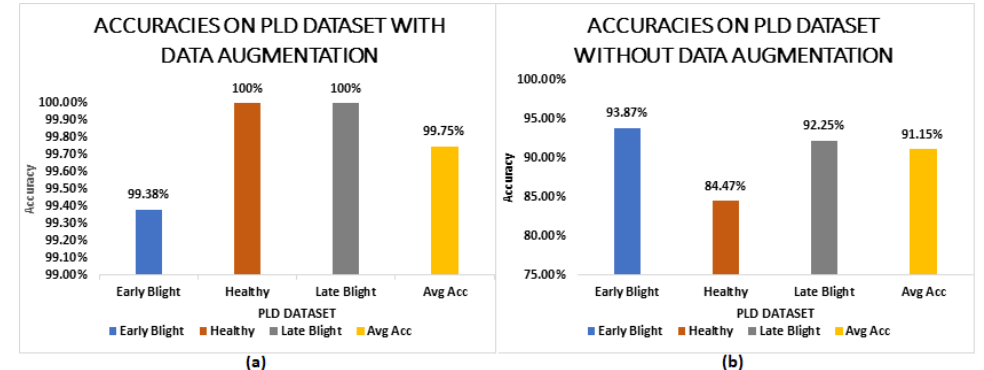
Figure 6. ( a ) Accuracies graph of PDDCNN on PLD with data augmentation. ( b ) Accuracies graph of PDDCNN on PLD without data augmentation.